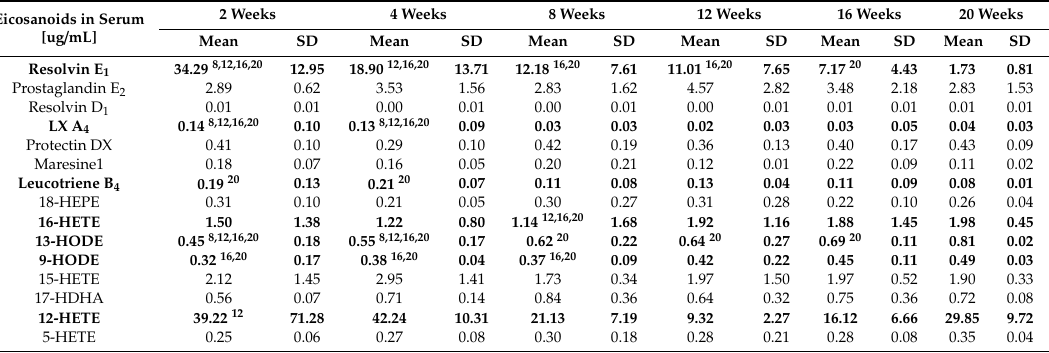
Table2. SerumeicosanoidsconcentrationduringNonalcoholicFattyLiverDisease(NAFLD)progression. 2 Weeks 4 Weeks Eicosanoids in Serum [ug / mL]